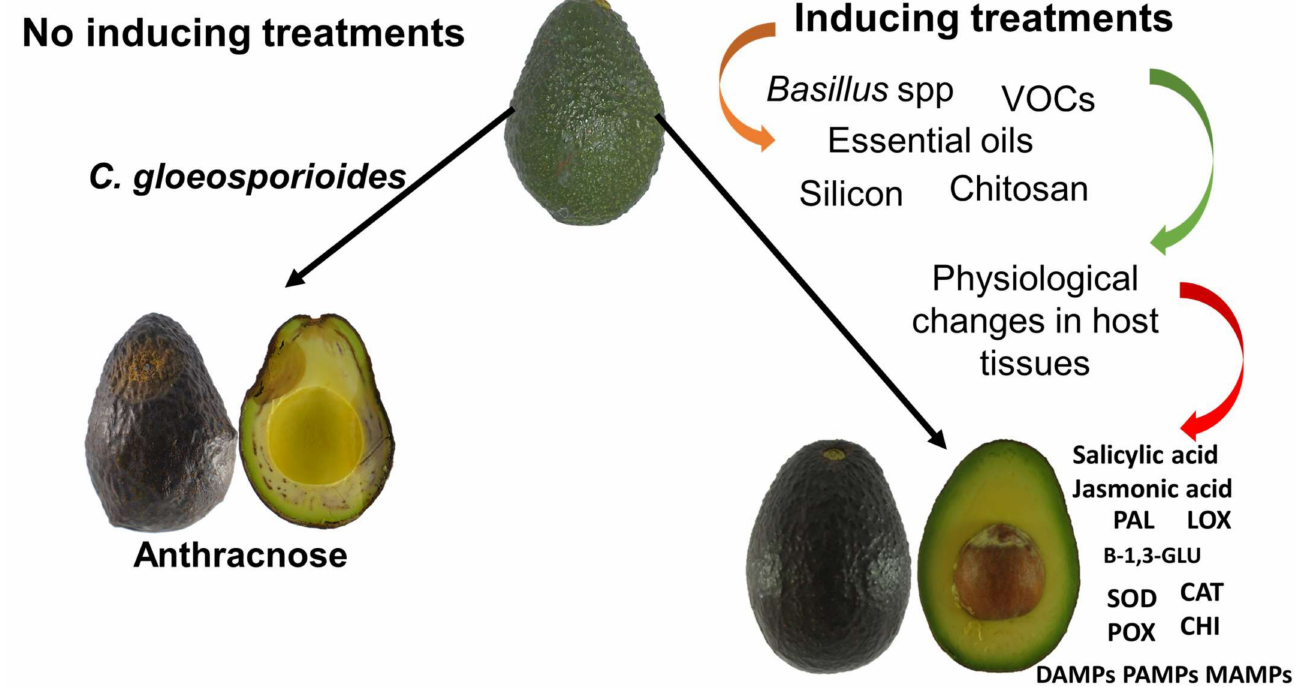
Figure 1. Anthracnose infection processes in preharvest, harvest, and postharvest until eating maturity without inducing treatments, and mechanisms of elicitation action of natural compounds in the fruit after their application to the fruit at harvest until eating maturity with inducing